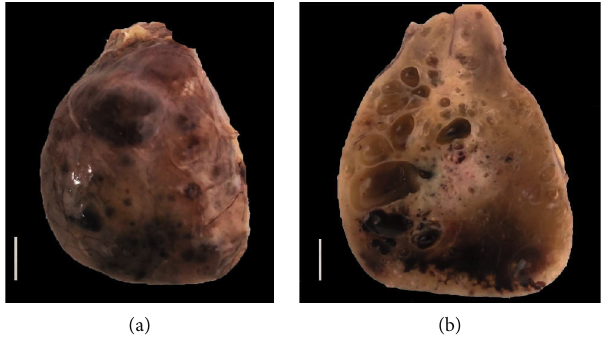
Figure 2: (a) Gross pathological appearance of giant parathyroid adenoma, which weighed 42grams, featuring intact capsule, cystic areas, and foci of congestion. Bar represents 1cm. (b) Cut section of the giant parathyroid adenoma featuring tan surface, areas of congestion or hemorrhage, and multiple cystic spaces that were fi lled with clear fl uid. Bar represents 1 cm.